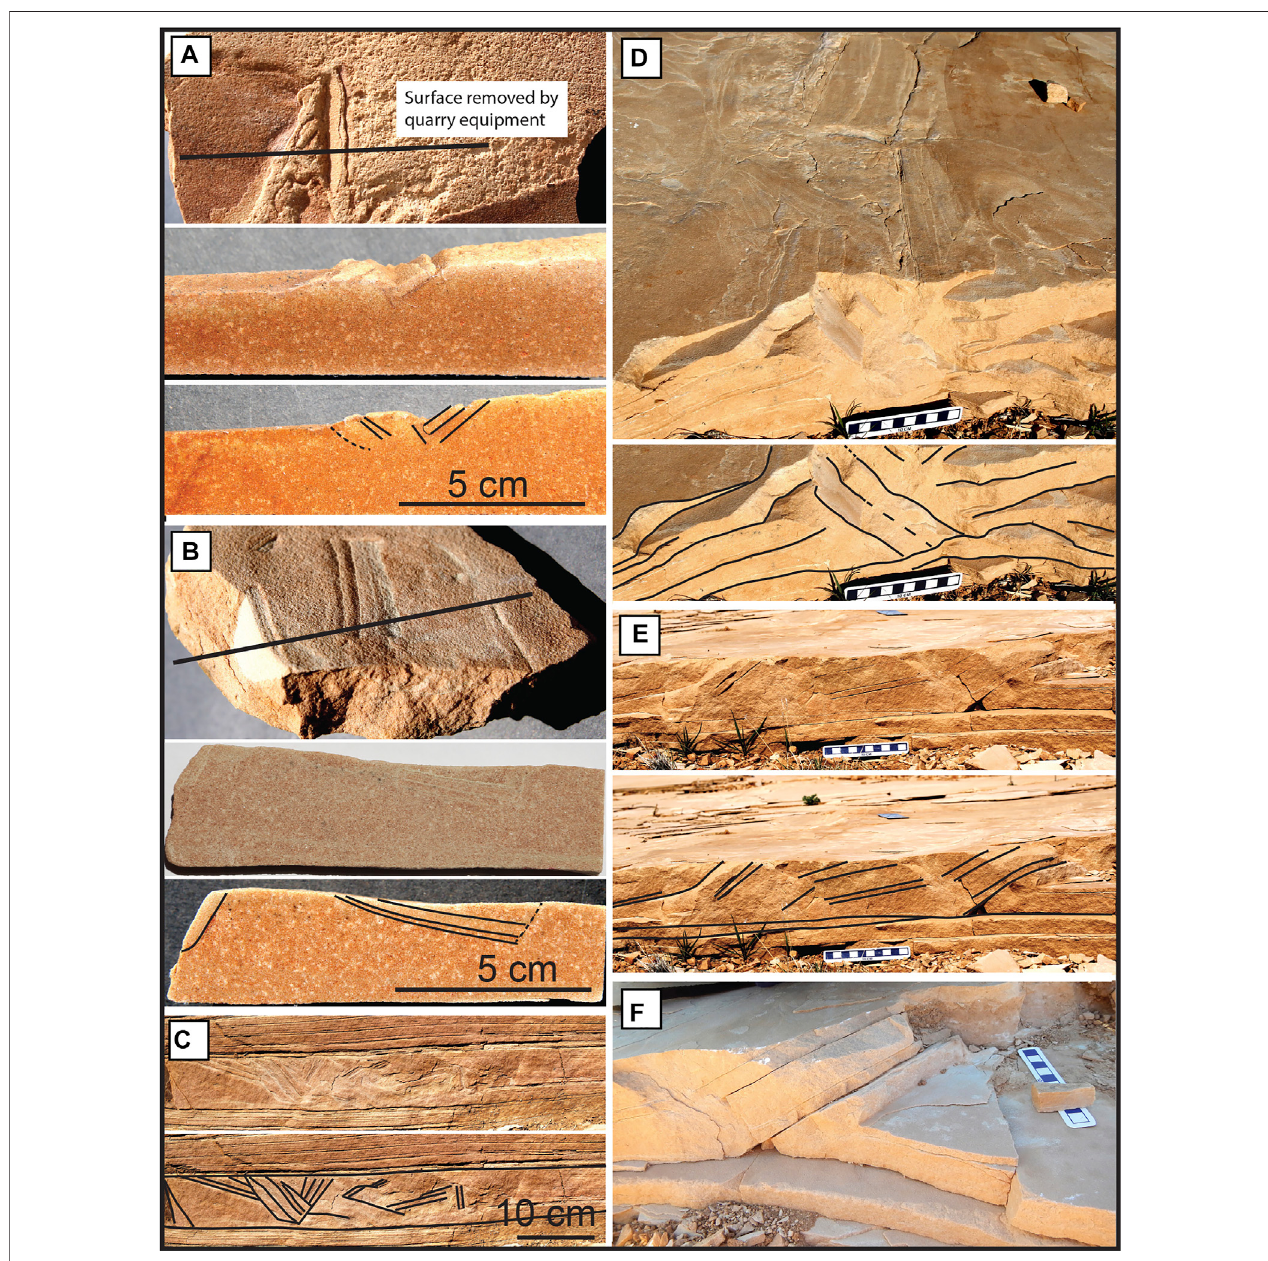
FIGURE8| Cross-sectionalviewsoffourSSDSs,withrotatedblocks.Theseareshownwithandwithoutlinesannotatingtherotatedportions (A – D) Surfaceviews ofthe structures, withheavyblack lines in (A,B) indicatingthetransectorientations (D – F) Differentviews ofasingle SSDS. (D) shows thesurface oftherotated blocks in (E,F) , and (F) is a close-up of the right portion of (E) . Scale bars in (D – F) are 10 cm long.